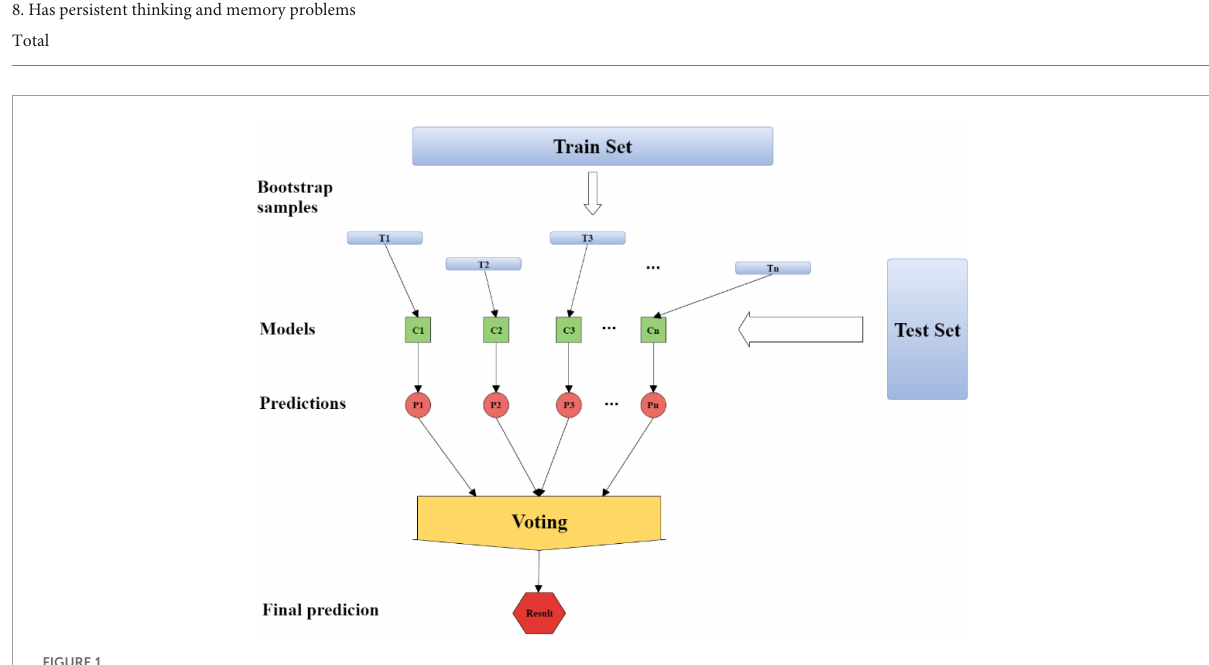
combination. First, 60% of the data set is used as the training set, and 40% of the data set is used as the test set. About 60% of the data is randomly and repeatedly extracted from the training set to establish T n sets of training data, and the T n sets of training data are used. Build C n models from the training data, substitute the data from the test set into C n groups of models to get P n answers, and finally get the results by voting or averaging for the n answers. The process of Bagging algorithm is shown in Figure 1